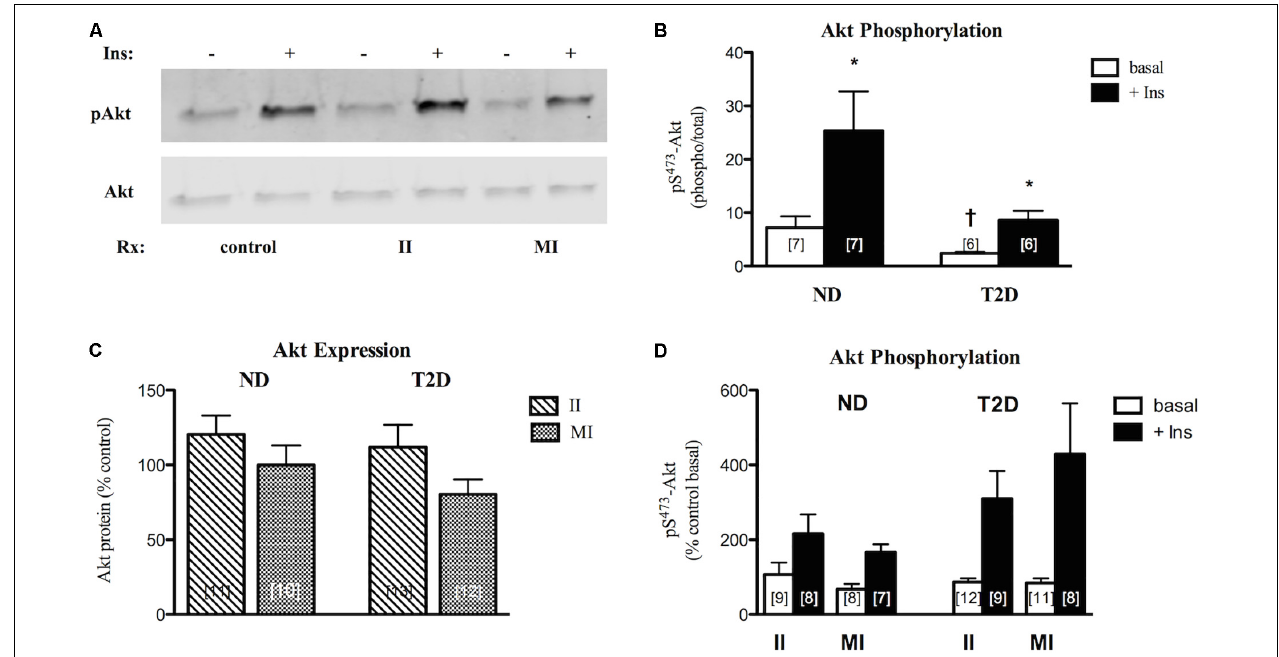
FIGURE 5 | Effects of II and MI conditions on MT function. (A) Representative western blots for total and phosphorylated (S 473 ) Akt after MT treated for 48 h. (B) Quantification of western blots for pS-Akt under control (w/o treatment) conditions. (C) Regulation of Akt protein expression by treatment. Results presented as a percentage of MT from the same individual w/o treatment. (D) Regulation of Akt phosphorylation. Results presented as a percentage of basal activity (phospho/total) in MT from the same individual w/o treatment, Ave + SEM. * p < 0.05 vs. basal, † p < 0.05 vs.